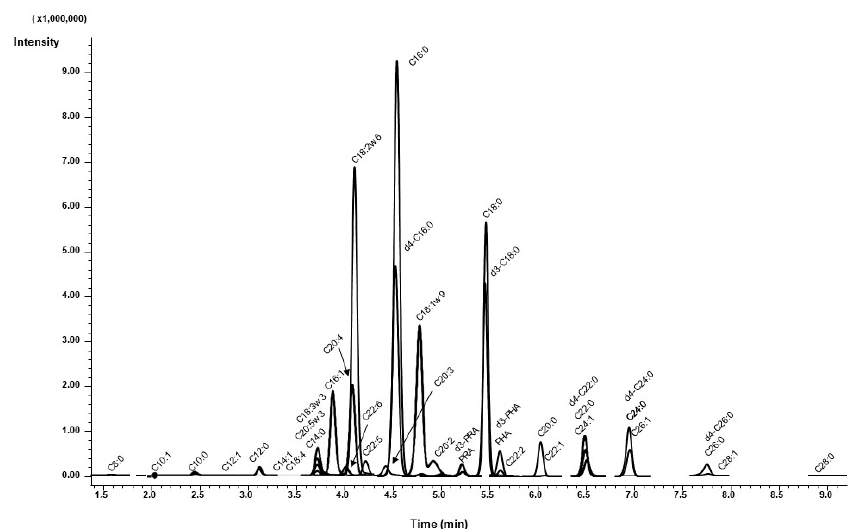
Figure 4. Representative multiple reaction monitoring LC-MS / MS, overlaid with chromatograms obtained by the current method.